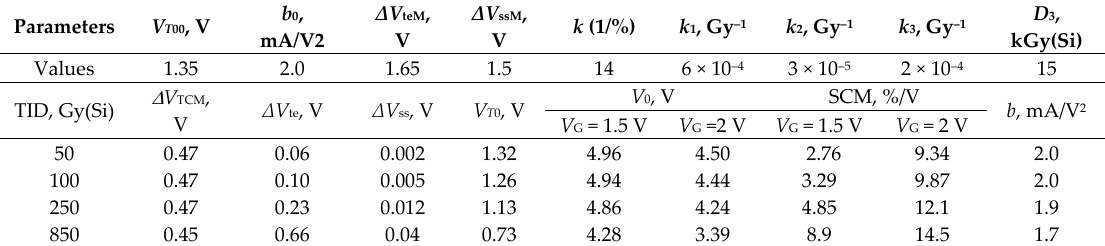
Table 1. Average values (dispersion < 10%) of MISFET’s, circuit’s and the model parameters